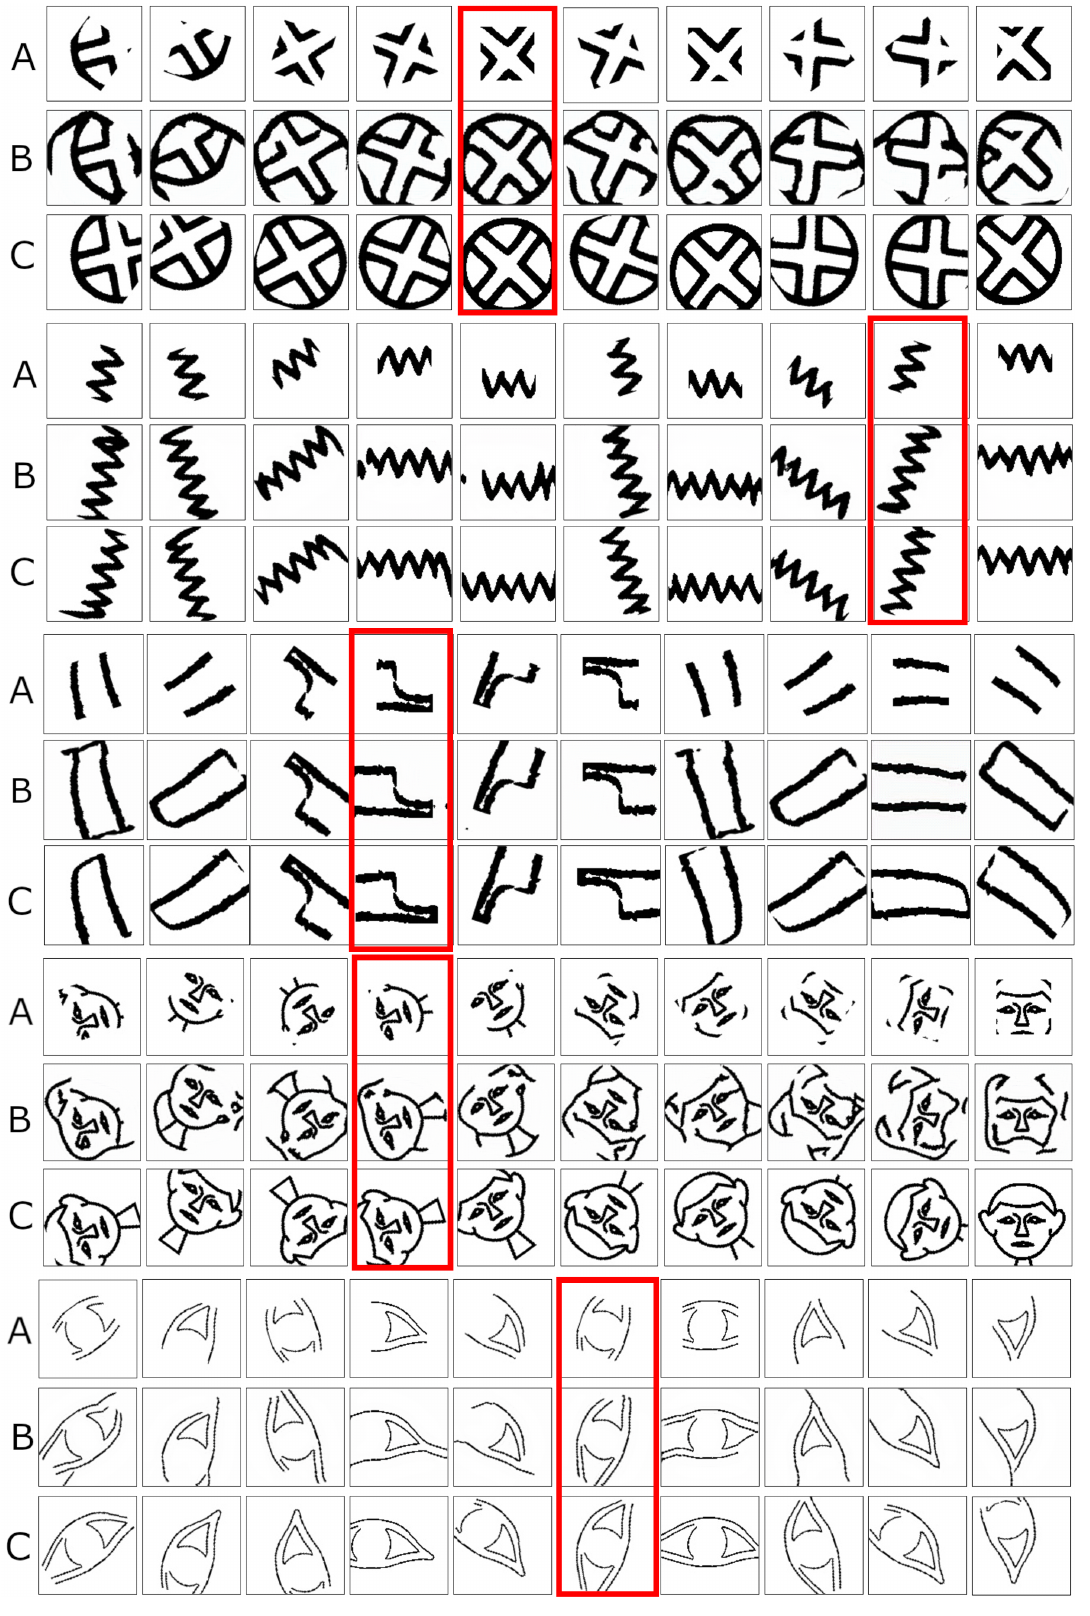
Figure 11. Examples of decoration completion for the circle, water, feather, head, and eye inscriptions. The rows are labeled as A, B, and C to indicate incomplete signs, predicted completion, and ground truth complete signs, respectively. The red rectangle highlights the best results, which are used to evaluate the generative